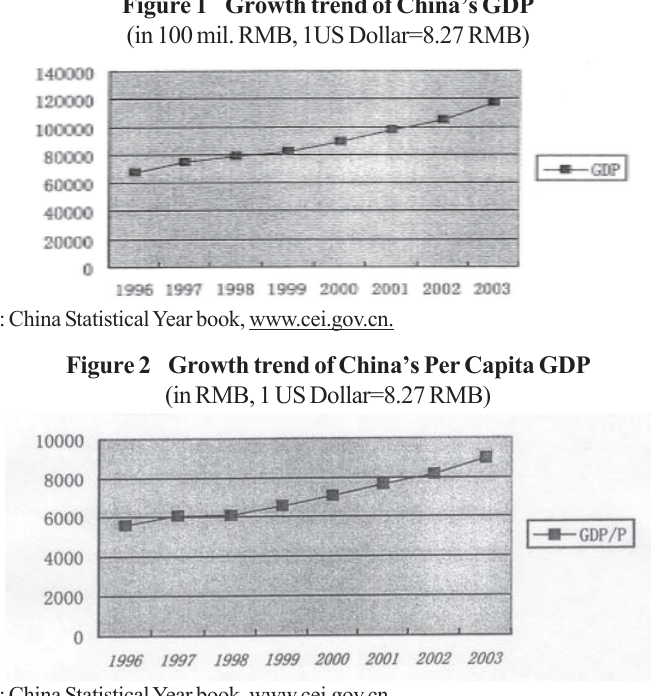
Source: China Statistical Year book,